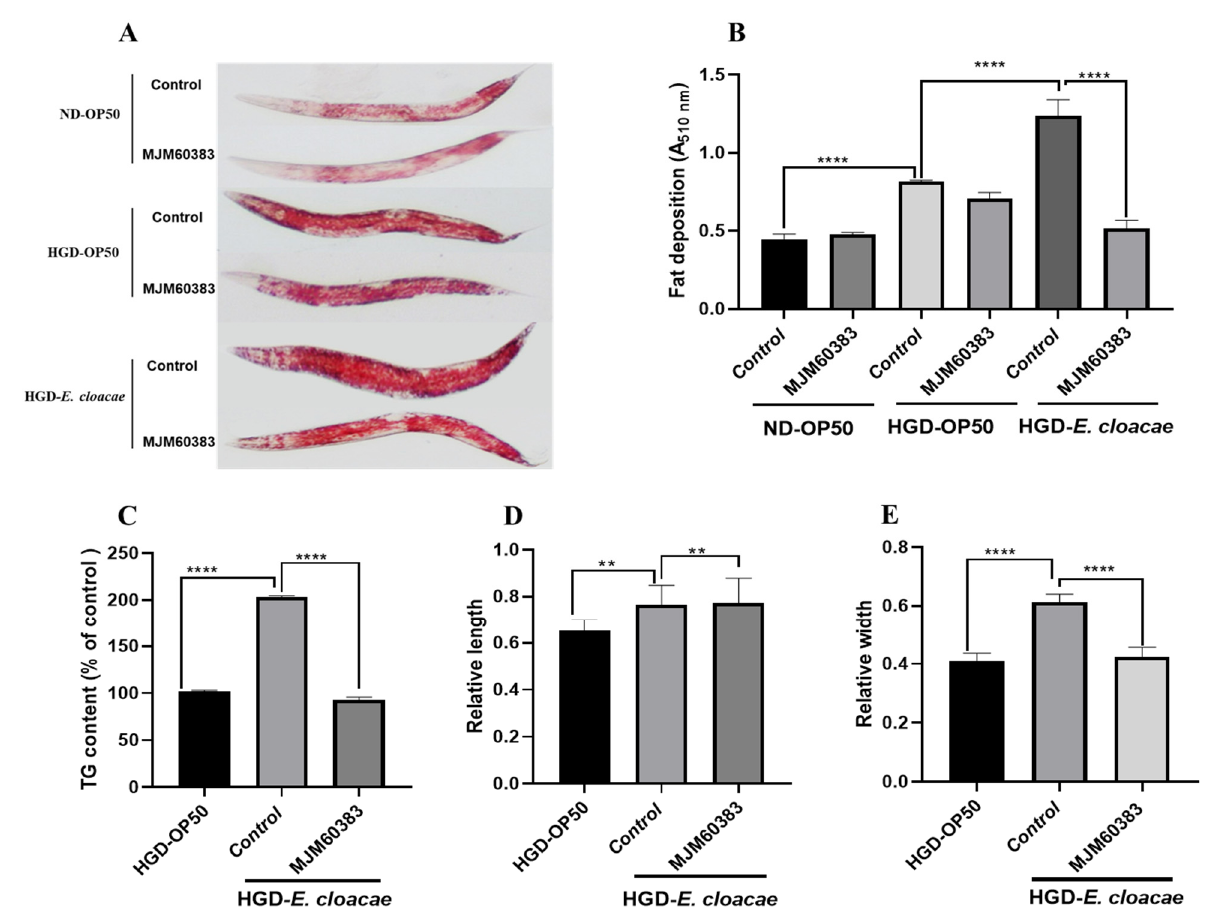
Figure 4. MJM60383 reduced the fat deposition and the TG content in the HGD- E. cloacae model. Synchronized L1 worms were fed with OP50, or E. cloacae (NGM plate supplemented with or without 100 mM glucose) for 37 h at 20 °C, then worms were transferred into new NGM plates supplemented with MJM60383 lawn and raised for 18 h at 20 °C. ( A ) Representative images of Oil Red O staining. ( B ) Quantification of ORO in each group. For Oil Red O quantification, the data were obtained from three independent experiments and 2000 stained worms were used in each experiment. ( C ) TG content in worms (n = 3, 2000 worms in each independent experiment). Triglyceride levels were normalized by protein content. ( D ) The relative length of worms (n = 25). ( E ) The relative width of worms (n = 25). Statistically significant differences between the treated group and control group were analyzed using the one-way ANOVA with Dunnett’s multiple comparison test (** p < 0.01, **** p < 0.0001).